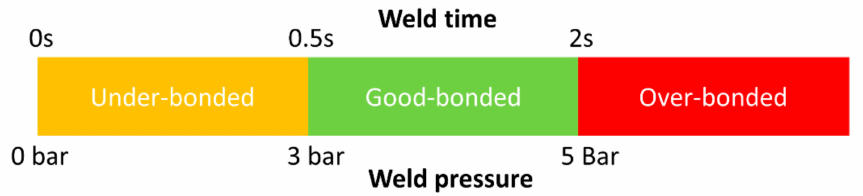
Figure7. Visualandmicroscopicpicturesofinitialweldingtrials( a – c )over-bonded( d )un-bondedjoints.